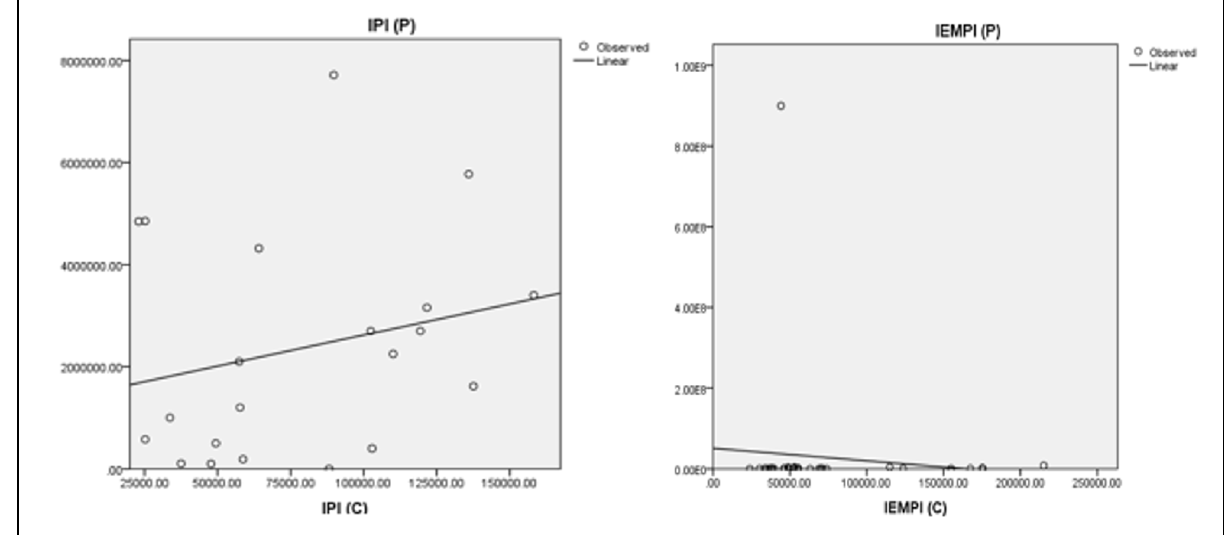
Figure 5c: The linear regression diagrams of cost/revenue analysis of industrial groups.